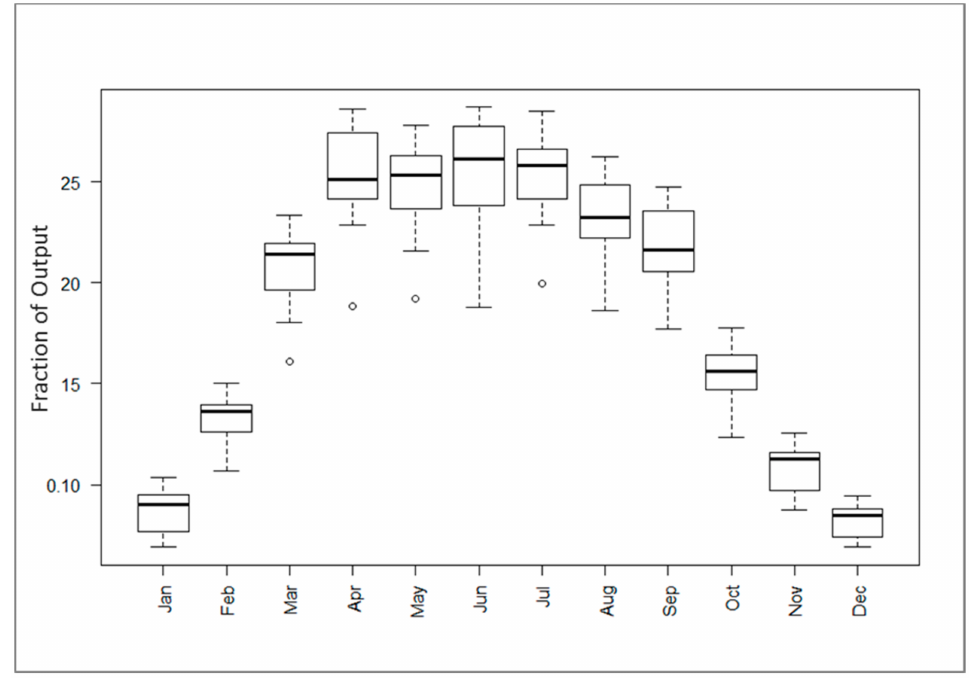
Figure 16. Boxplots illustrating variability of average monthly fraction of output for each DNO